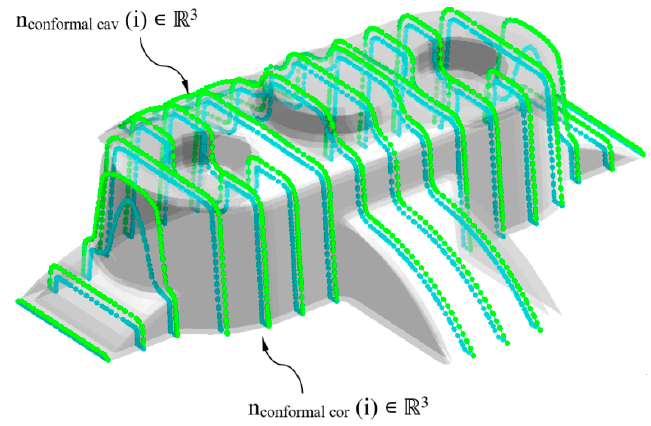
Figure 9. Demoldability analysis of the plastic part discrete geometry.